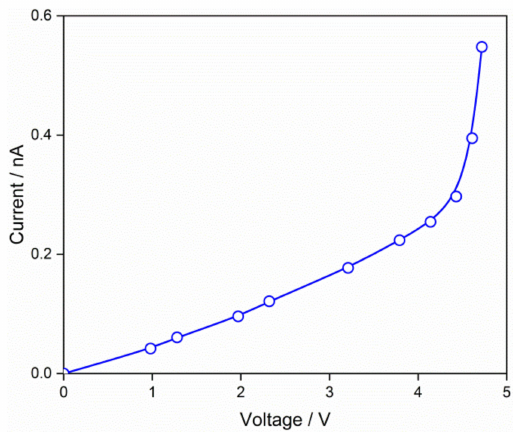
Figure 7. Voltage-current characteristics of the thin film prepared from the QD0